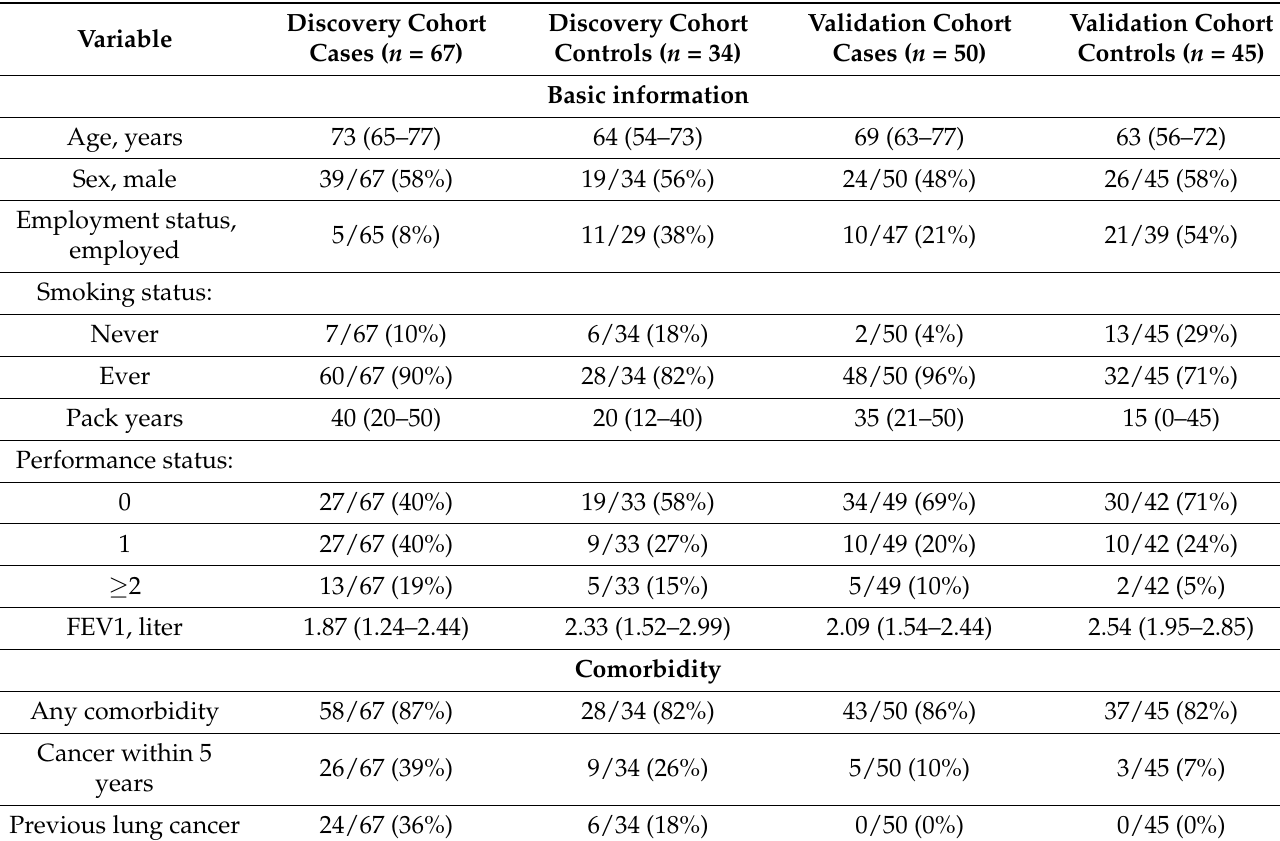
Table 1. Participant characteristics for the Discovery and Validation cohorts, respectively, separated into columns for cases and controls. Continuous variables are reported as median (interquartile range, IQR), and categorical variables are reported as fraction (percentage, %). As a result of rounding, not all categories add up to